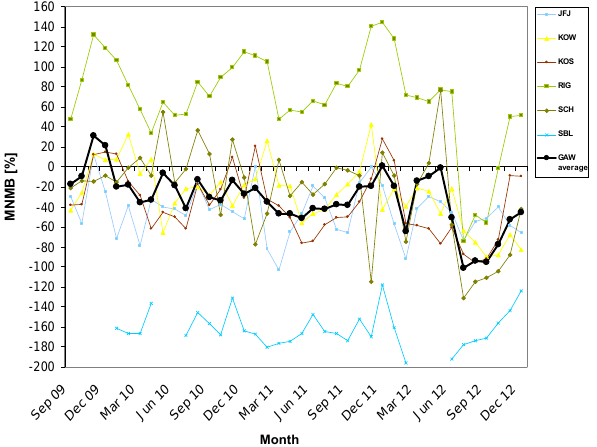
Figure 21. Modified normalised mean bias (MNMB) in % derived from the evaluation of the MACC_osuite with GAW NO 2 surface observations over the period September 2009 to December 2012 (black line: global average of six GAW stations, multi-coloured lines: individual station results; see legend to the right).